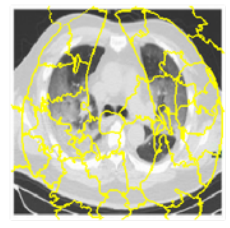
Figure 8. Super-pixels on a sample chest CT scan